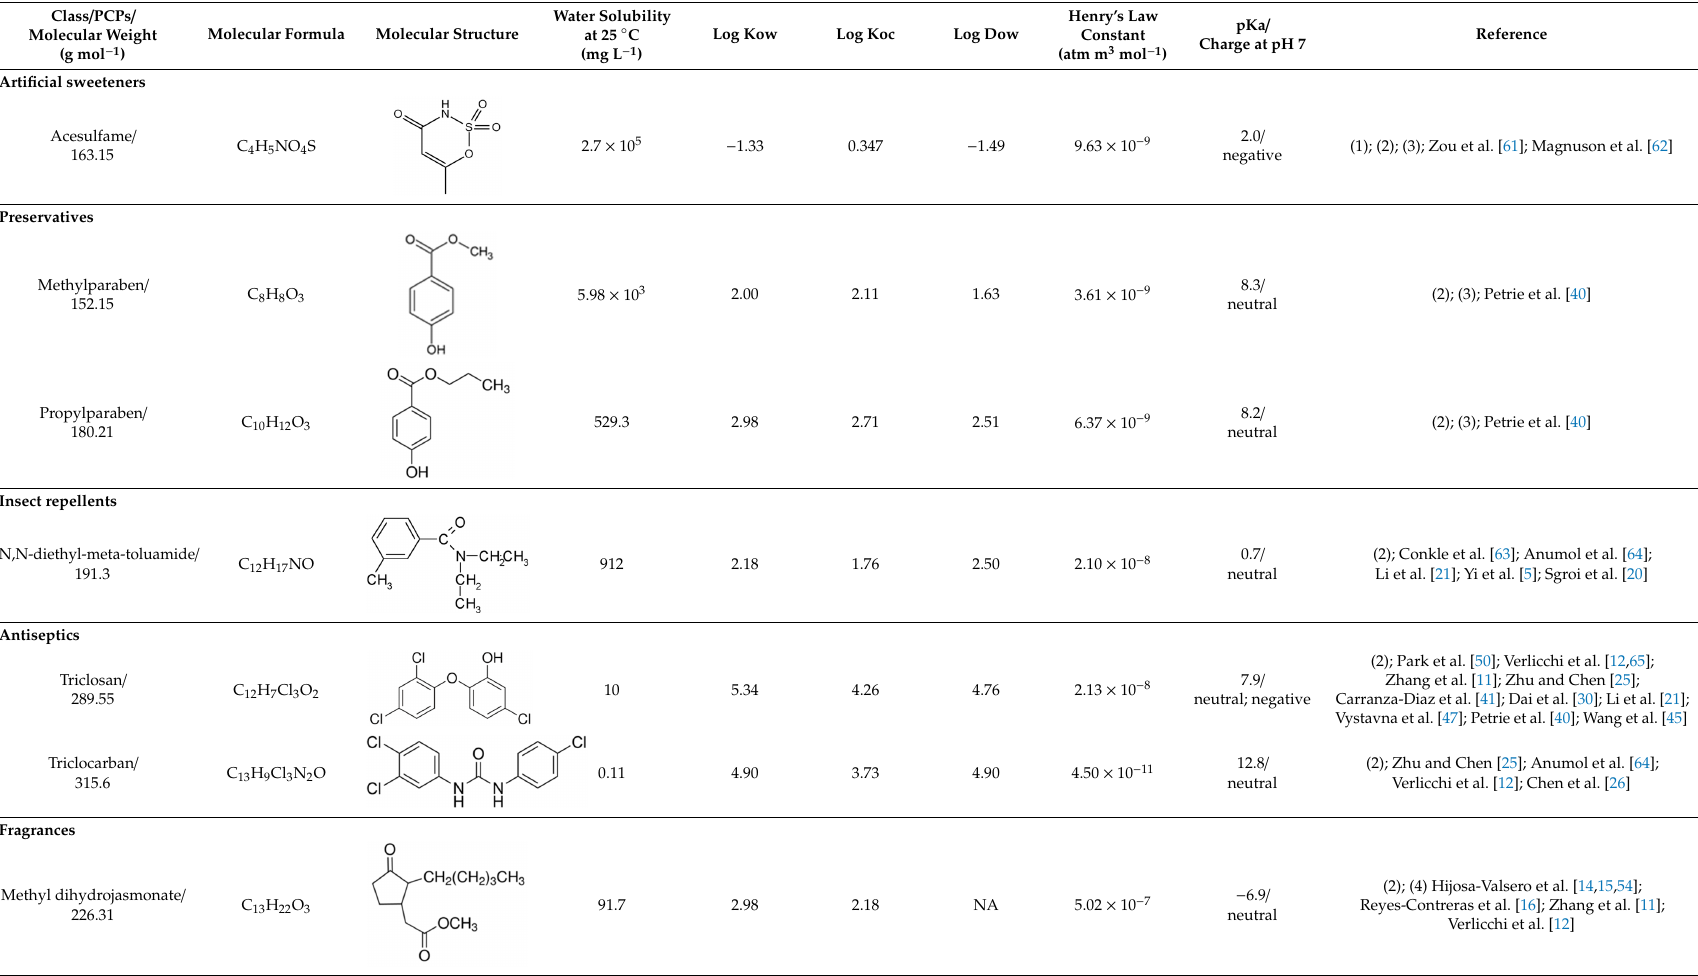
Table 4. Physicochemical properties of 15 selected PCPs.